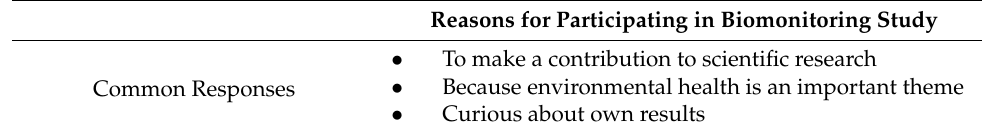
Table 4. Common responses to the topic of study